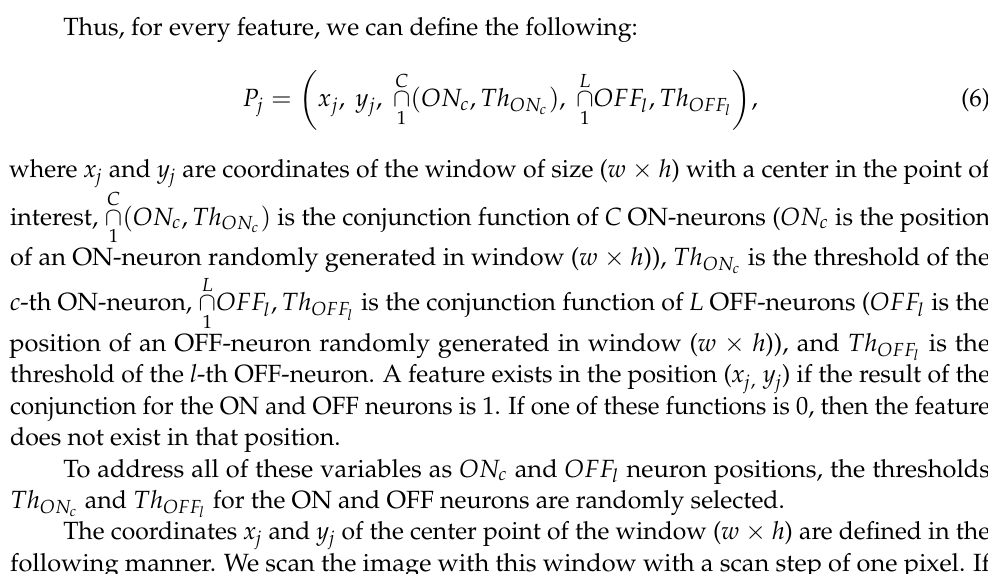
Figure 10. Same features in different places: ( a ) White lines with the same inclination; ( b ) Different pairs of feature frames from the man’s lips.